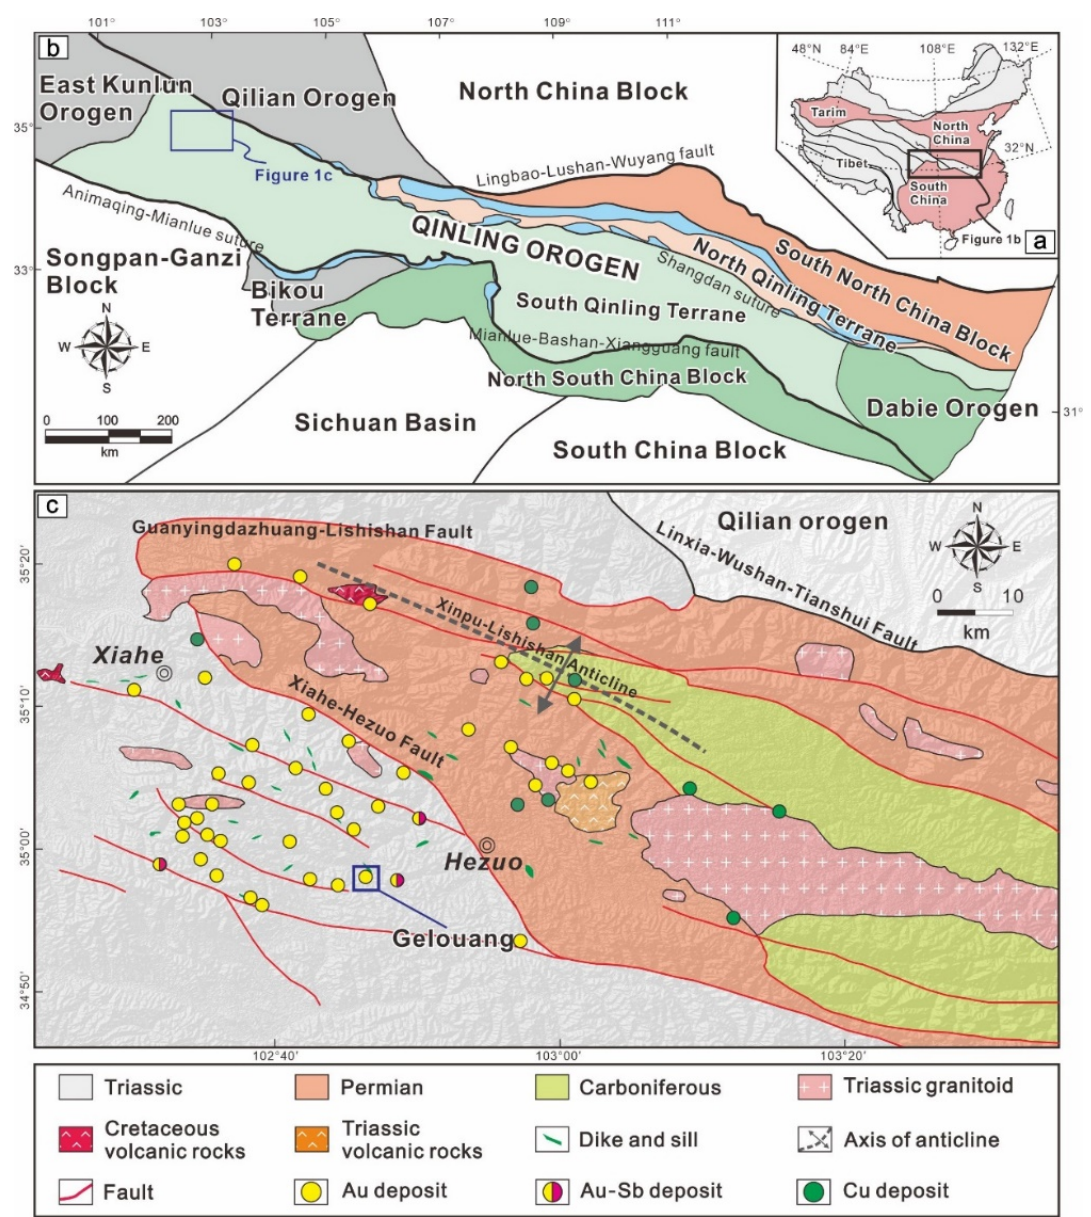
Figure 1. ( a , b ) Major tectonic domains of China and the location of the Qinling Orogen. ( c ) Digital elevation model with superimposed geological map of Xiahe-Hezuo district of the western Qinling Orogen showing faulting and ore deposits (modified after [45–47]).